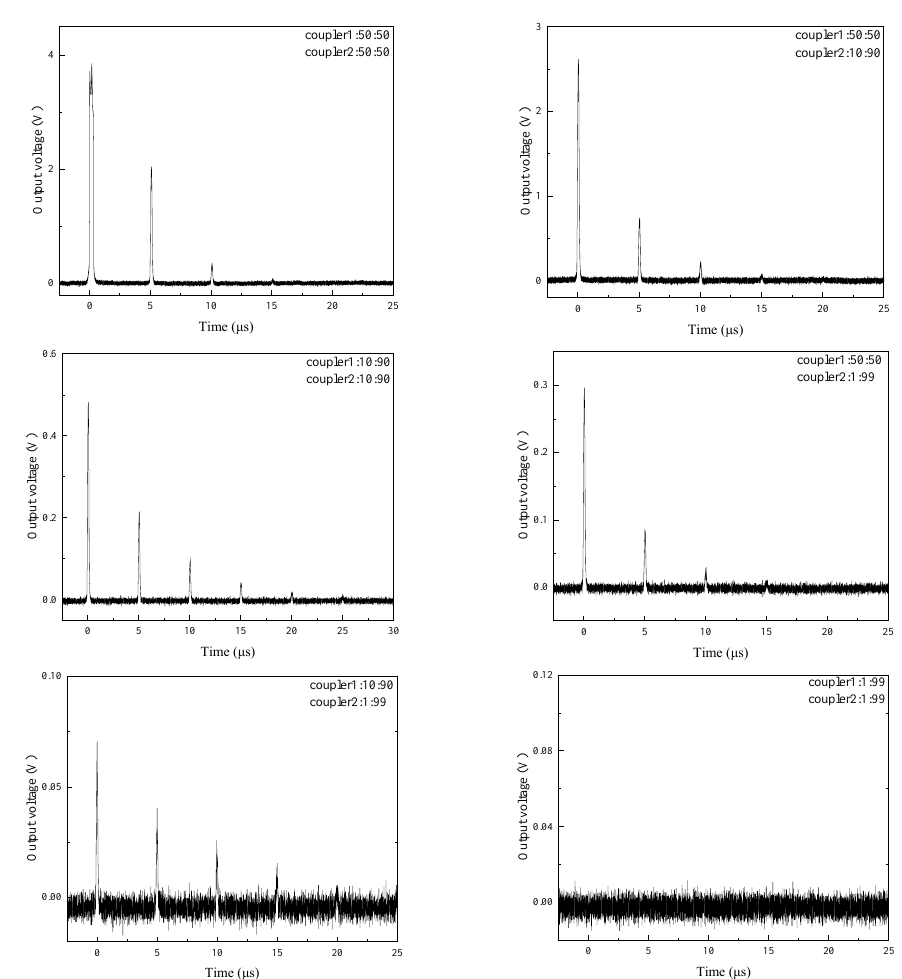
Figure 3. The attenuated pulse waveforms under different collocations of the couplers. Table 1. The detected signal results under different collocations of the couplers.